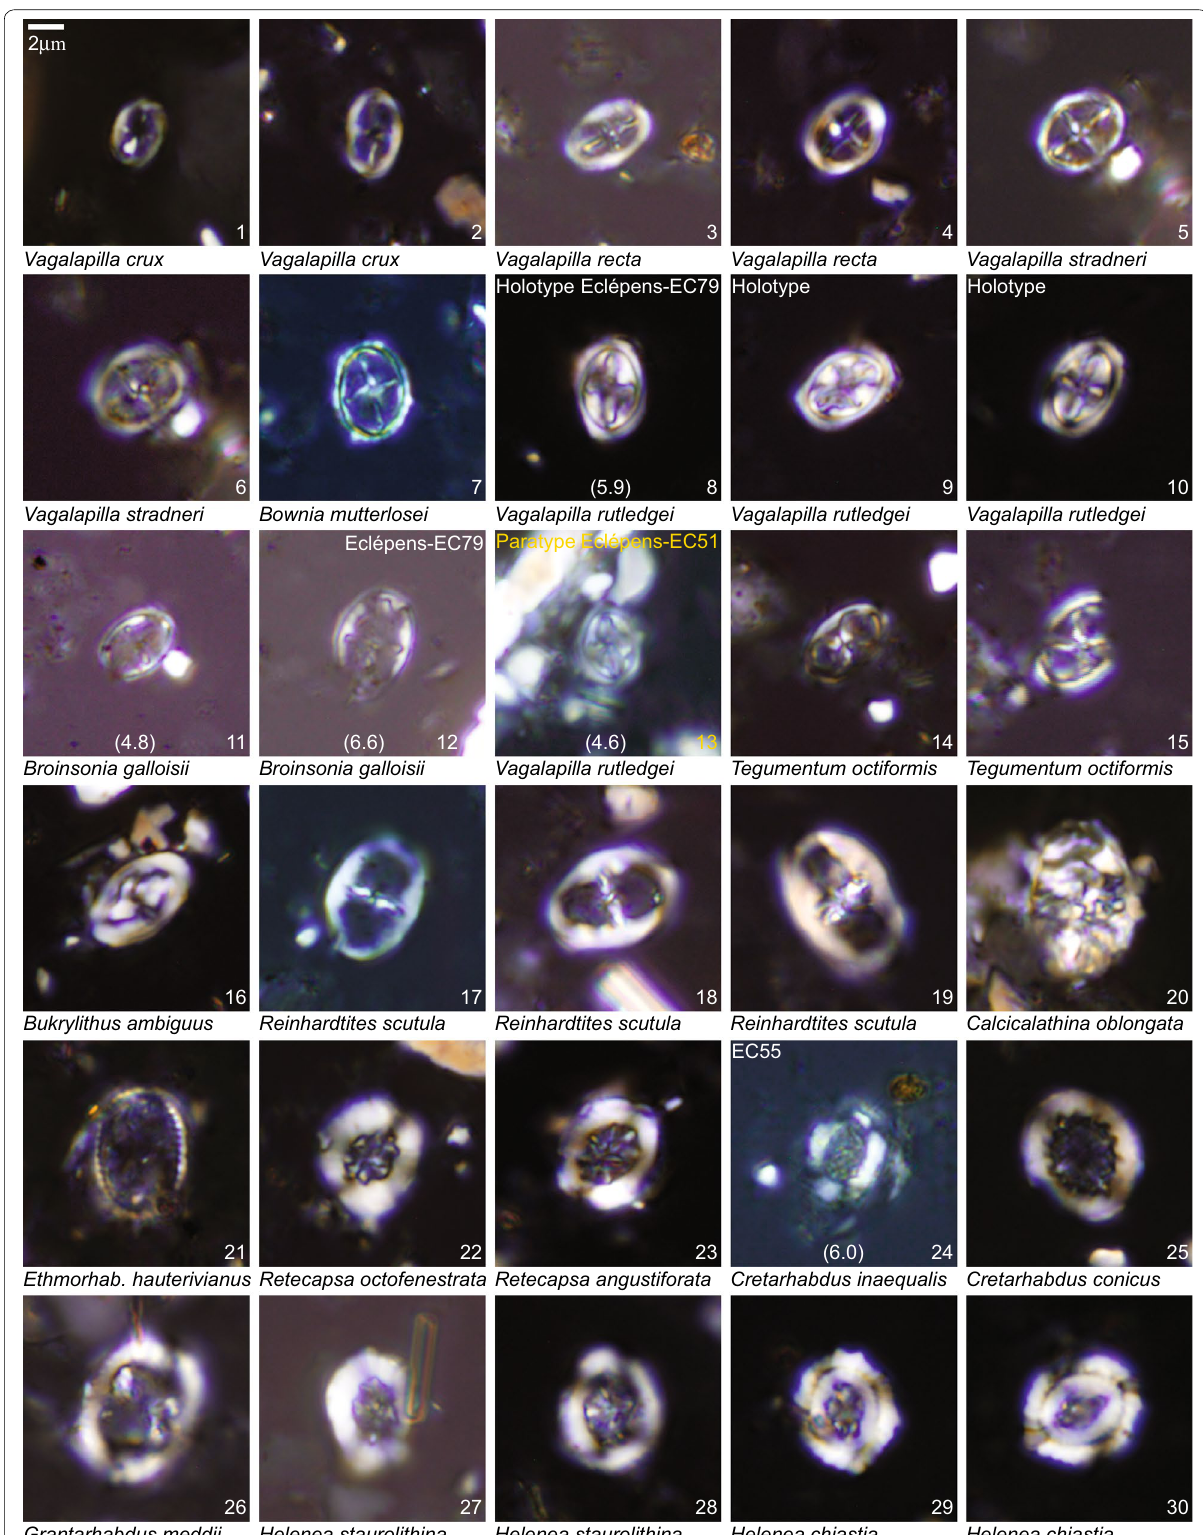
Fig. 9 Calcareous nannofossils from the Marnes de la Russille (Barremian) of the Swiss Jura Mountains. All LM pictures from La Sarraz–Les Buis quarry (without sample numbers: LSBMRu1) and Eclépens quarry (with sample numbers: